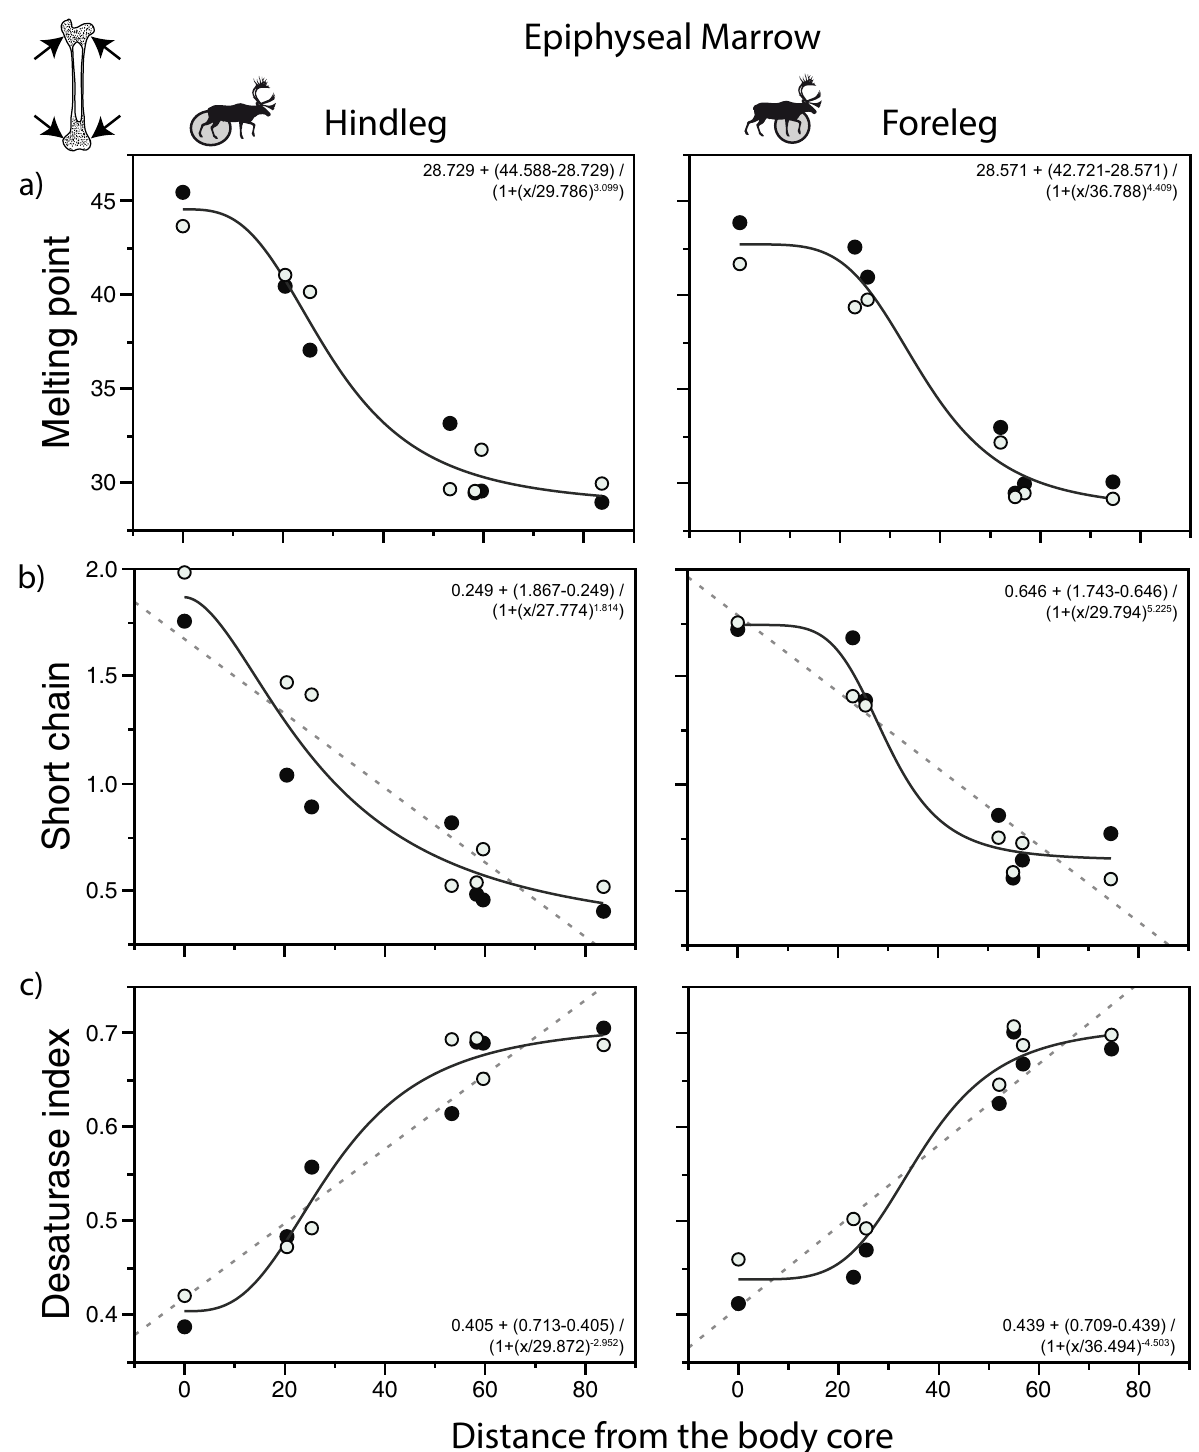
Fig 5. Relationship between fatty acid (FA) parameters and sample distance in the epiphyseal marrow of caribou. a) weighted melting point (in ˚C); b) percentage of short chain saturated FA; c) Δ 9 desaturase index. Bold curves assume a sigmoidal function; dashed curves are relationships that show a better fit with a linear function according to the AICc values (S1 Table). Melting point and FA values calculated as in Fig 3. Distance data from S1 Fig, FA data from Table 2. The regressions were calculated using the mean for the two individuals. Closed circles: individual A; open circles: individual B. “0” were replaced by “0.0001” in the calculation of the sigmoidal function as the model cannot be computed with the former